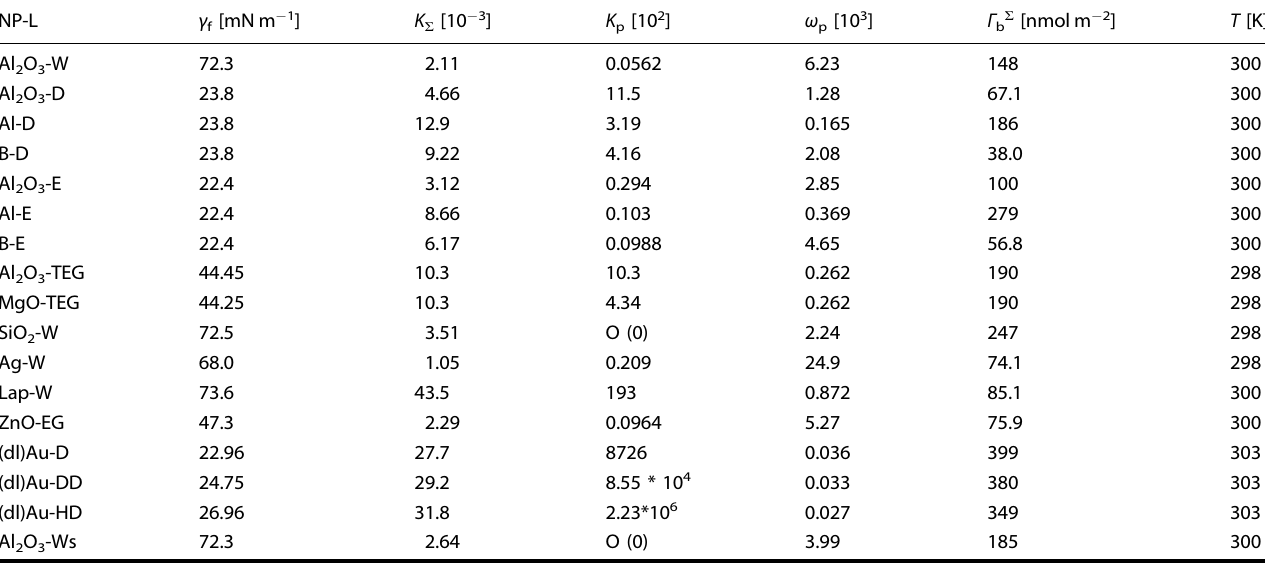
Table 5. Calculated parameters used in Eq. (25) for the nanoparticle dispersions.